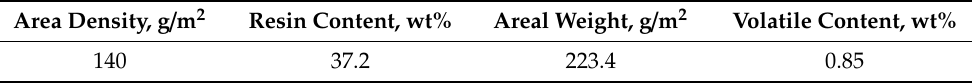
Table 3. Physical property of high temperature rosin-sourced epoxy / UN-SYT49S prepreg.